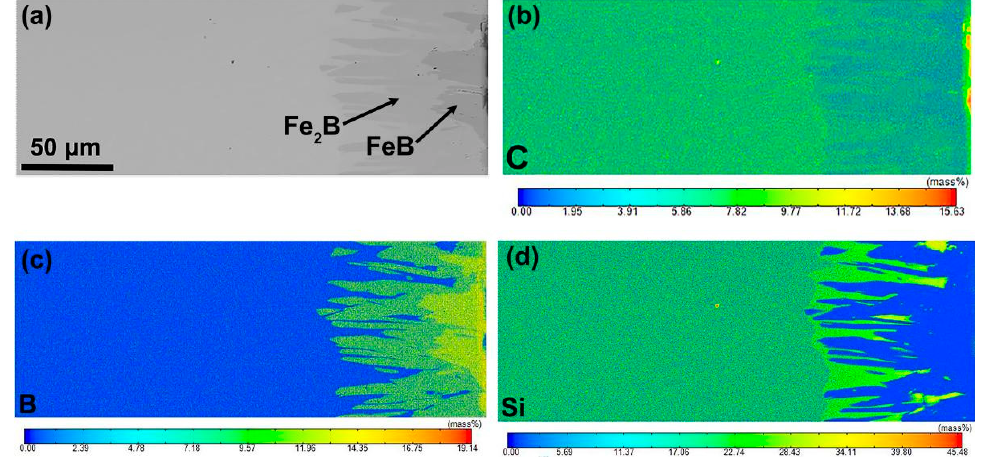
Figure 7. Map scanning of elements along the depth of the produced layer from the surface of sample